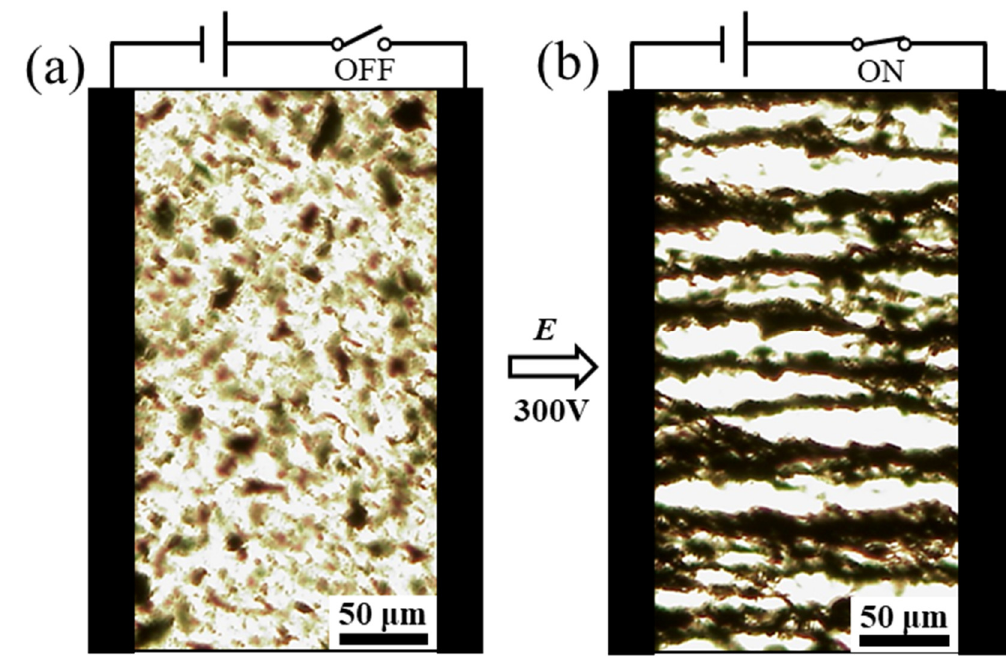
Figure 4. Optical microscopic images of GO/PDPA microsheet composites-based electrorheological (ER) fluid (10 vol.%) when the electric field was ( a ) off and ( b ) on (300 V).